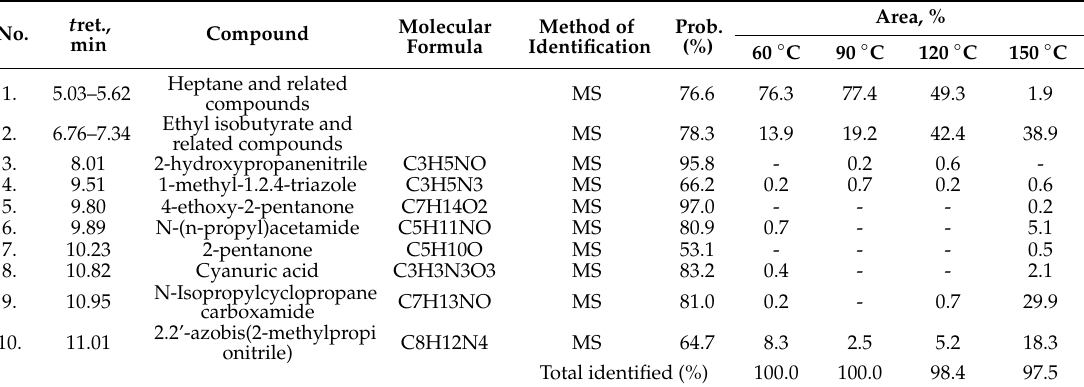
Figure 9. Comparative view of total ion chromatograms (TIC) of liquid material from irradiated p( N iPMAm) hydrogel volatiles obtained under di ff erent oven temperatures. Table 4. Chemical composition of the volatiles present in the headspace of liquid material from irradiated p( N iPMAm)